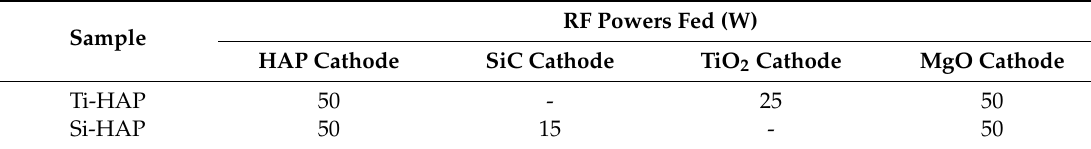
Table 1. RF power fed applied on used